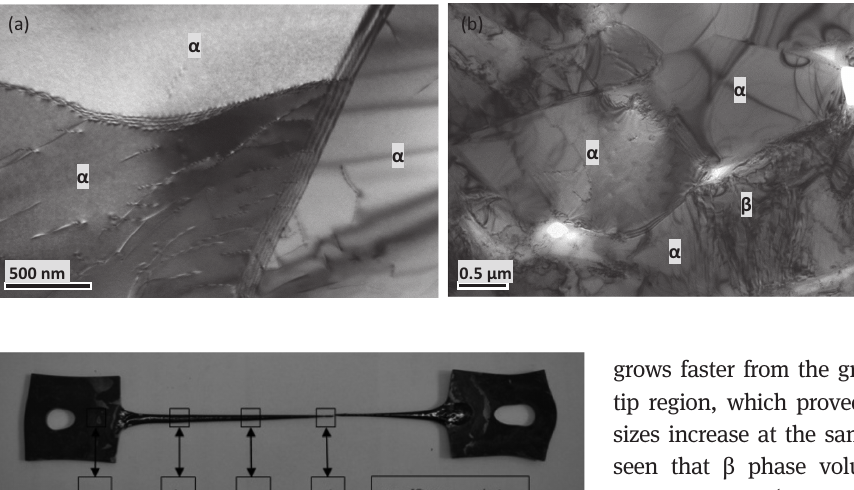
Figure 10: Various cutting points in the specimen.